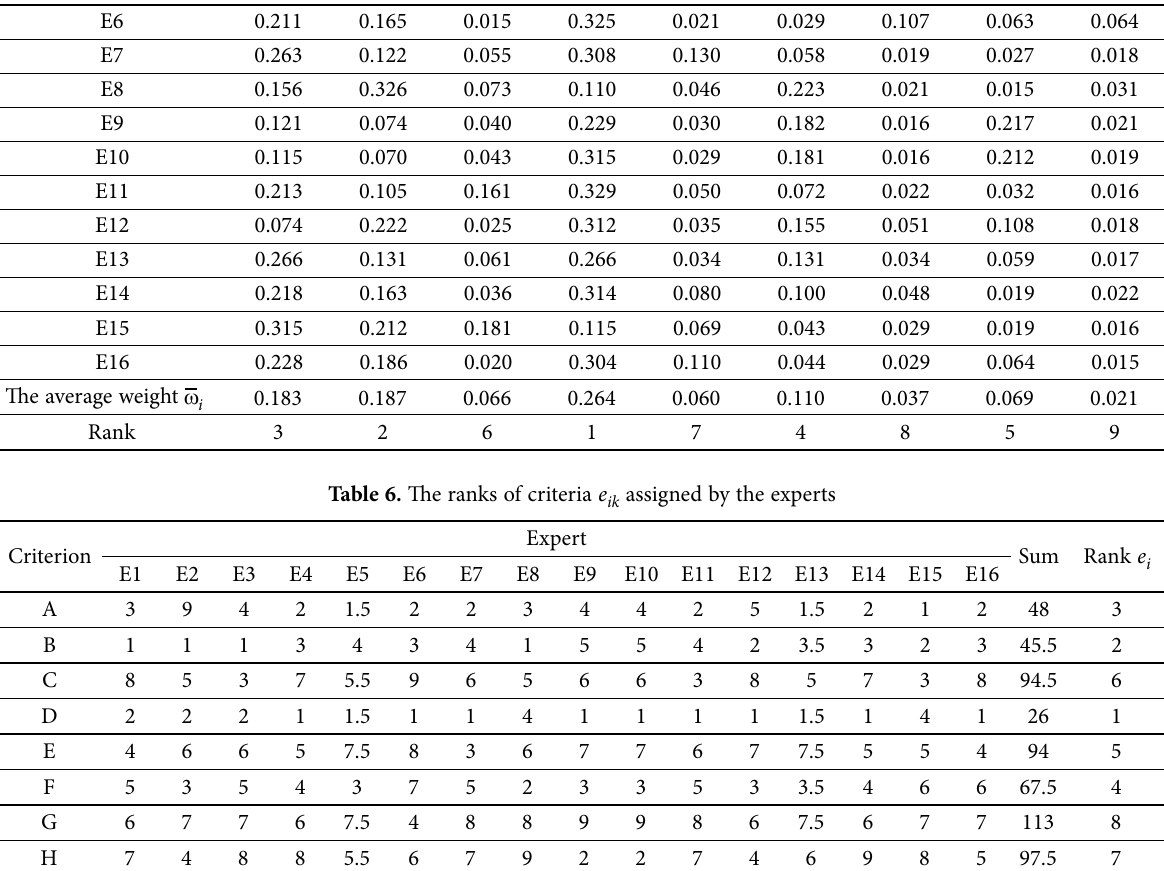
Table 5. Weights ω ki calculated for evaluation criteria of all experts Expert